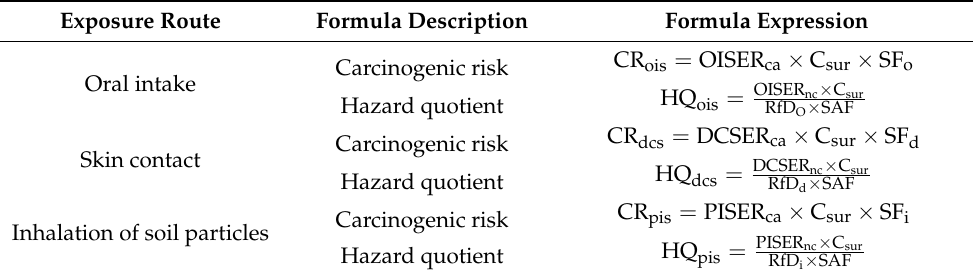
Table 3. Carcinogenic risk and hazard quotient calculating formulas for three soil exposure